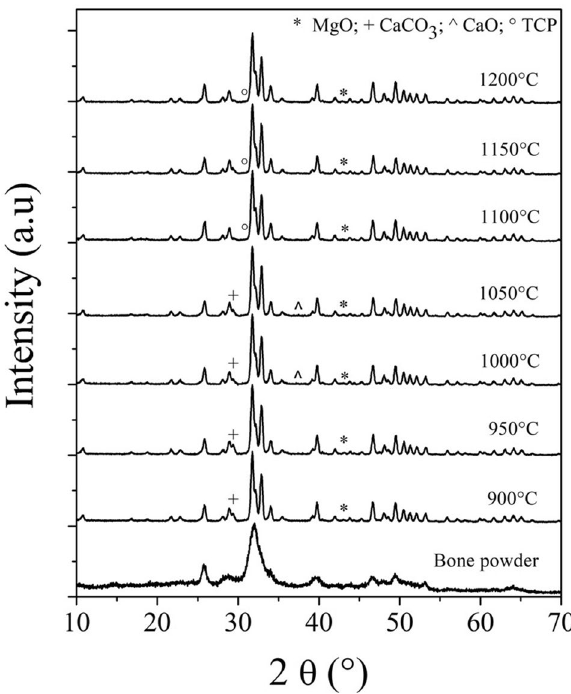
Figure 1. XRD patterns of the samples treated at different calcination temperatures.